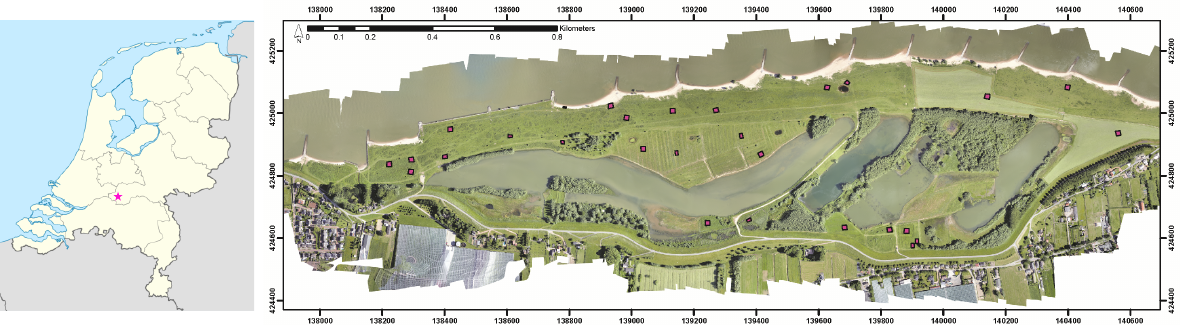
Figure 1. Location of study area in the Netherlands (left). Orthophoto of Breemwaard in June with fieldplots in magenta